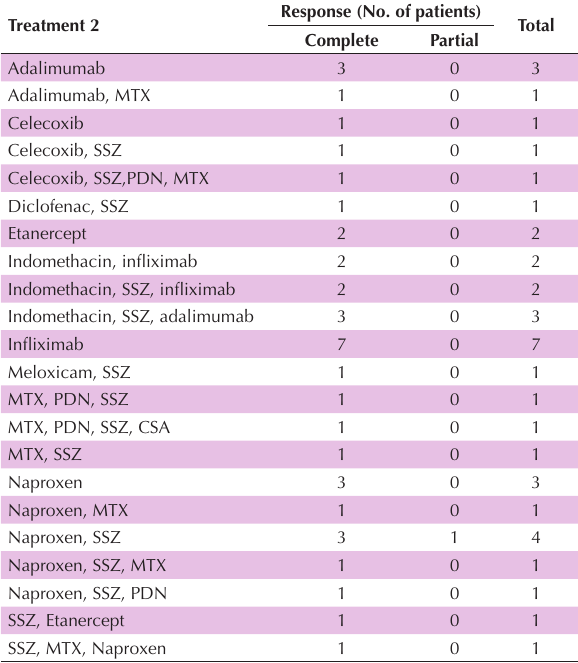
Response (No. of patients)